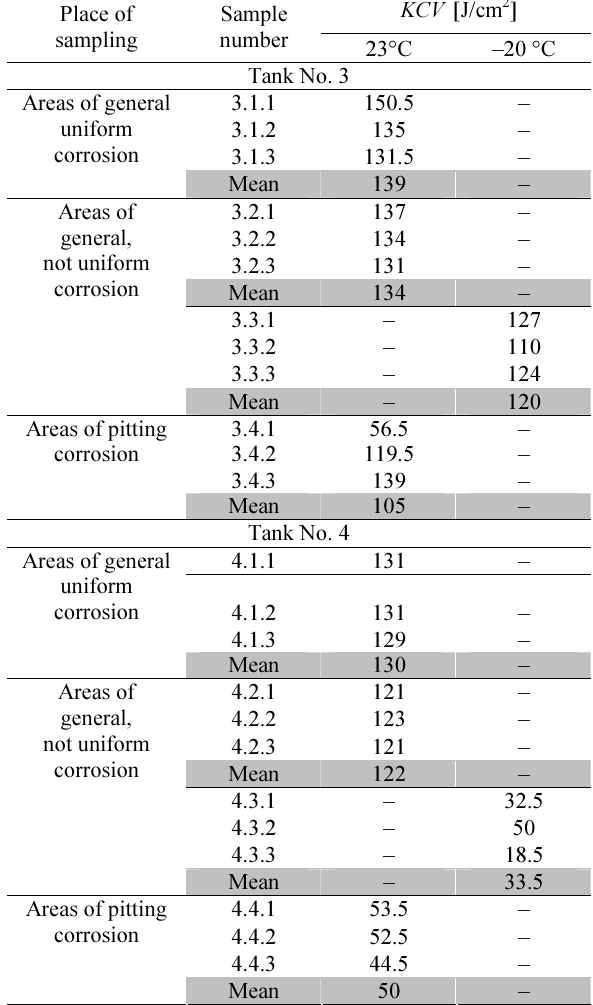
Table 4. Results of KCV impact resistance test for steel from